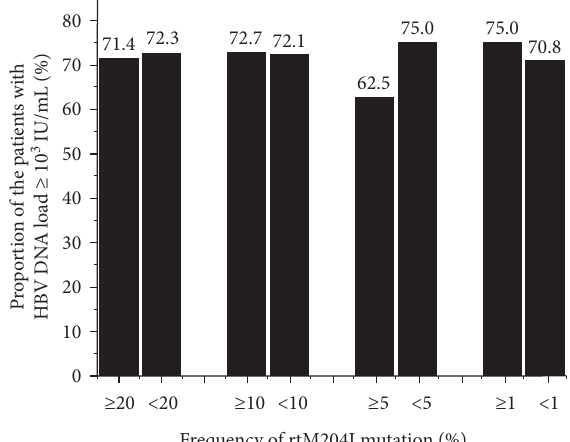
Figure 3: Relation between the frequency of rtM204I and maternal HBV DNA load at delivery. HBV: hepatitis B virus.